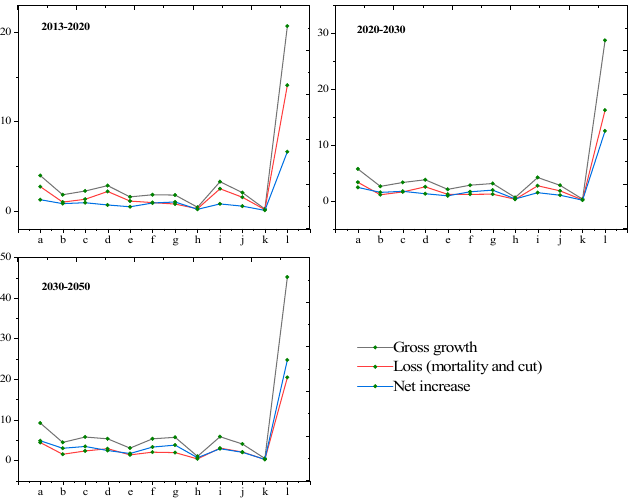
Note: Loss (mortality and cut) = total loss × (volume of the species/volume total).